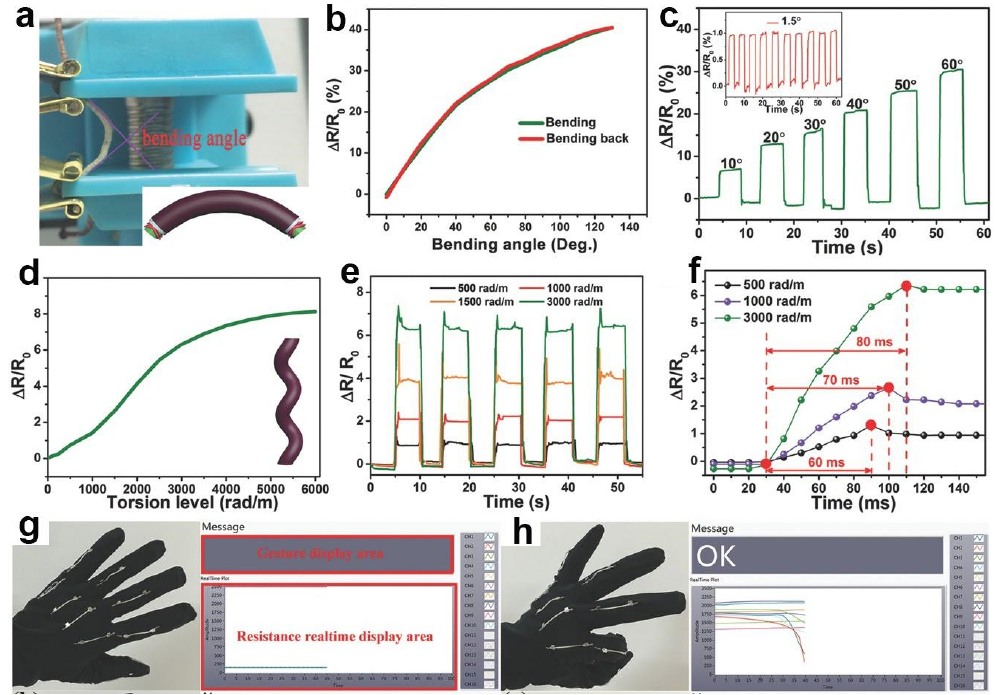
Figure 14. Bending and torsion sensing behavior of PU fiber coated in poly(vinylidenefluoride-co-trifluoroethylene) (P(VDF-TrFE)) and AgNWs: ( a ) Fiber sensor bending test setup and bending angle defined; ( b ) resistance response when fiber bent in forward and backward directions; ( c ) change in fiber resistance upon application of various bend angles. Inset: cyclic testing to 1.5 ° bending angle; ( d ) change in fiber resistance upon application of torsion test up to 6000 rad m − 1 ; ( e ) results of cyclic torsion testing under varying degrees of torsion; ( f ) response time testing for torsion detection; ( g ) “data glove” produced with strain sensing fibers and corresponding software to indicate finger movement; ( h ) “data glove” providing different output corresponding to hand gesture. Reprinted with permission from [115]. Copyright 2016, John Wiley and Sons: Hoboken, NJ, USA. Table 5. Fiber-based strain sensors coated with metals. Materials Fabrication Sensing Mechanism Sensor Properties